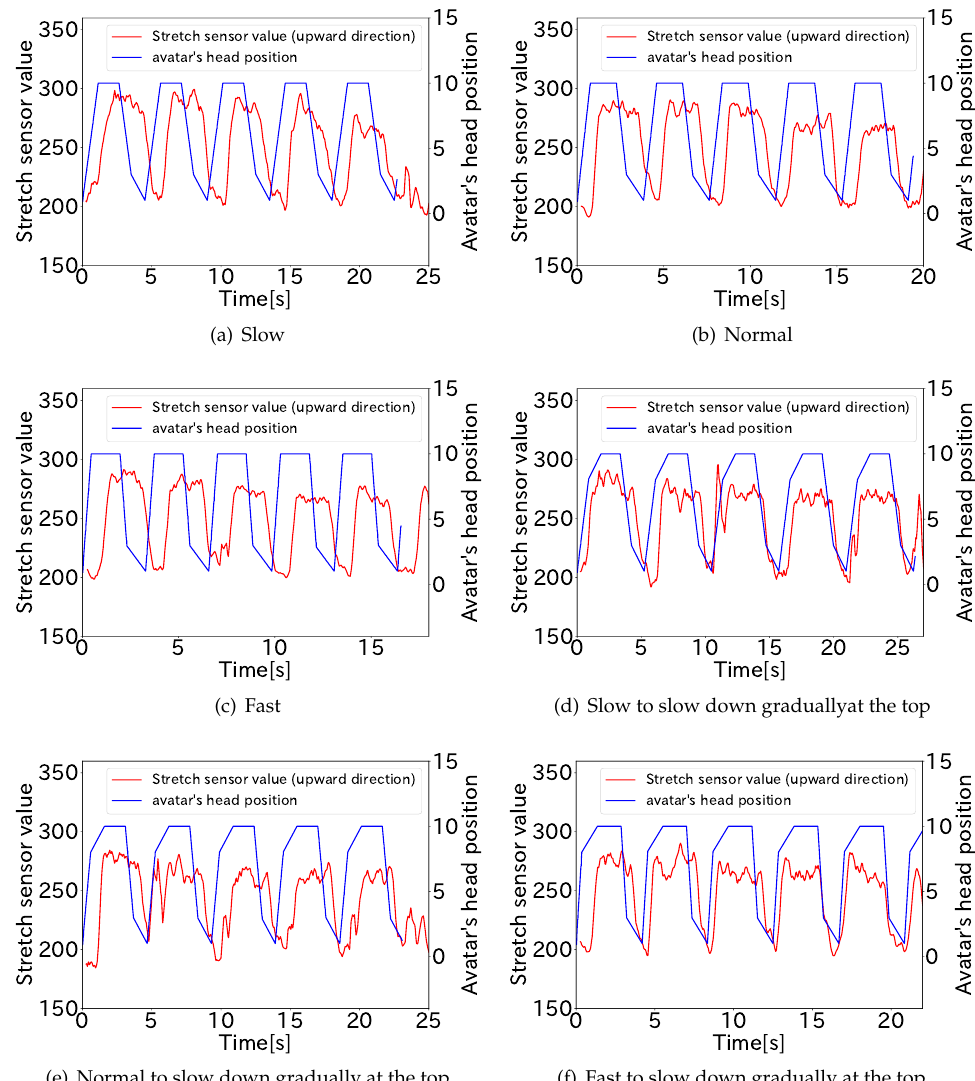
Figure 7. Stretch sensor values at each stretch speed in the upward direction (Participant